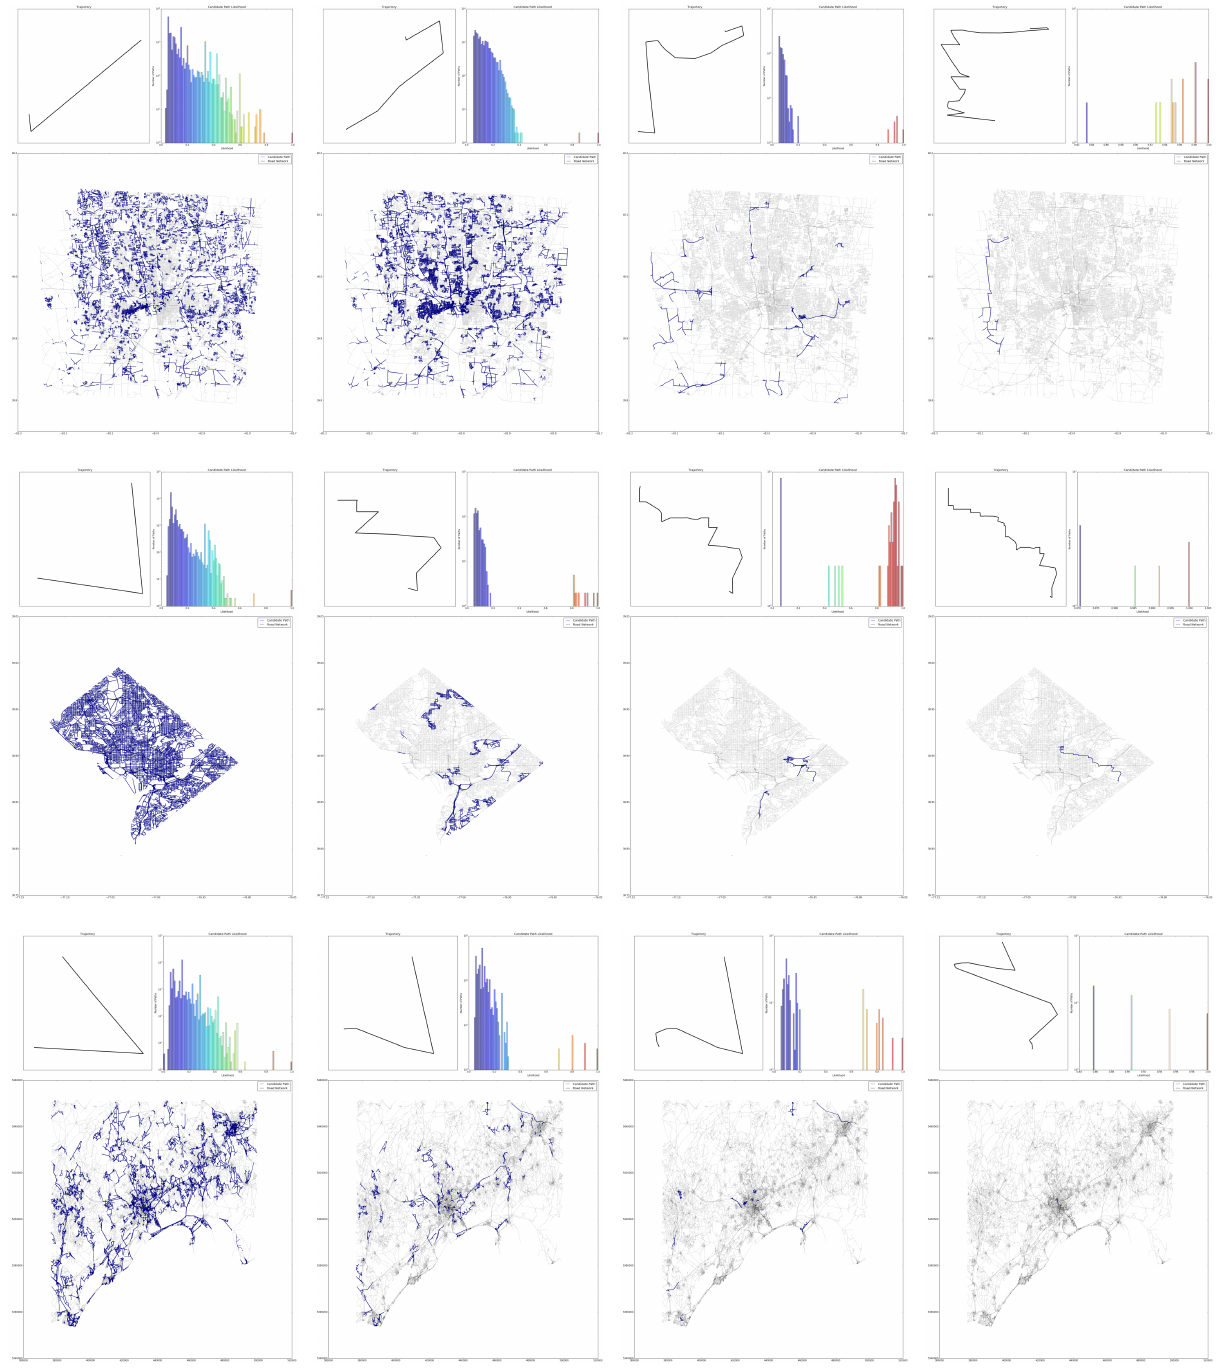
Figure 10: Geo-localization of mobile platform trajectory, from top to bottom for the geographic regions of ’Franklin County, Ohio’, ’Washington DC, US’, and ’Montpellier, France’. The estimated trajectory of the mobile platform is shown on the top left; the histogram on the top right shows the match score of each candidate path; and the map shows the current candidate paths. In the first column, the initial trajectory T V O is small and several candidate paths G P are spawned. The similarity match score is shown in the histogram graph. As T V O grows several G P are pruned since S ( G τ , G P ) ≤ threshold . Finally, the best matching path G ∗ right column, which is used for inferring geo-location of the mobile